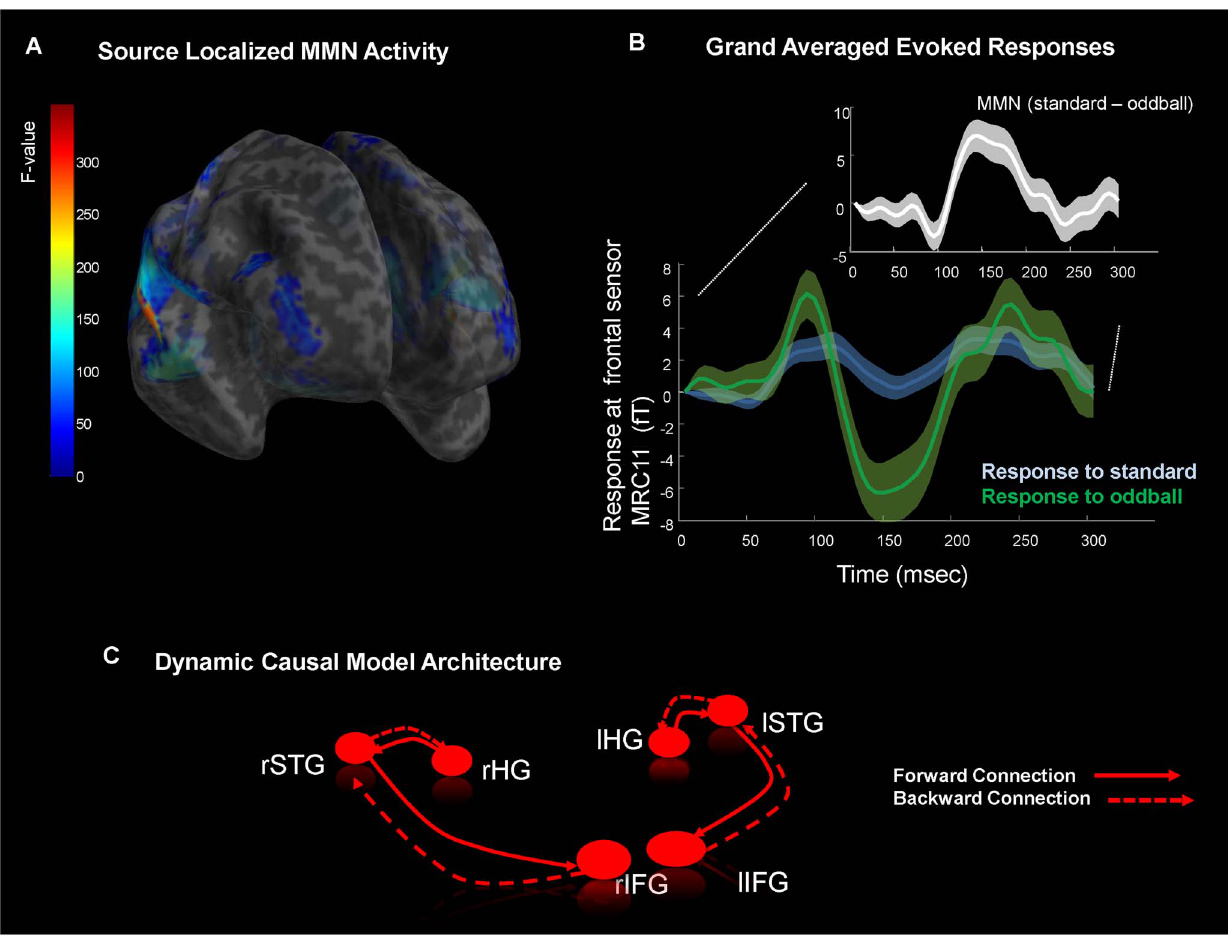
Figure 2. Mismatch Network. A) Statistical parametric mapping of mismatch (standard – oddball) effect across subjects ( p , 0.05 FWE corrected) sharing a color-coded F statistic on a semi-transparent canonical cortical inflated mesh. This SPM compares the power (in frequencies from 0–30 Hz, over 60–300 msec of peristimulus time), evoked by oddball stimuli with the equivalent power evoked by standard stimuli. B) Auditory evoked responses recorded at one MEG sensor over right frontal cortex. Plotted are the grand averaged evoked measurements across all sessions (shaded areas represent their standard deviation) in response to standard tones (blue) and oddball tones (green). The difference in these responses constitutes the mismatch negativity (MMN); seen here as the negative differences from 100–200 msec (white inset) – as predicted from the literature. Both types of trials were fitted for each subject in the DCM analysis. C) In the DCM, we modeled the transmission of neuronal activity from primary sensory to frontal regions using three sources reciprocally connected in each hemisphere; source location priors were as follows: left HG: x= 2 42, y= 2 22, z=7; right HG: x=46, y= 2 14, z=8; left STG: x= 2 61, y= 2 32, z=8; right STG: x=59, y= 2 25, z=8; left IFG: x= 2 46, y=20, z=8; right IFG: x=46, y=20, z=8. Inputs entered Heschl’s gyrus bilaterally and were passed via forward connections to STG within each hemisphere. STG sent top- down backward connections to HG. STG also sent forward connections up to IFG and received backward connections from IFG. Each source is modeled in the DCM with a neural mass model. The parameters of synaptic interactions within each source, as well as the extrinsic connections between sources were optimized during model inversion. The extrinsic connectivity was equipped with an additional parameter that allowed for different connection strengths during standard or oddball stimulus